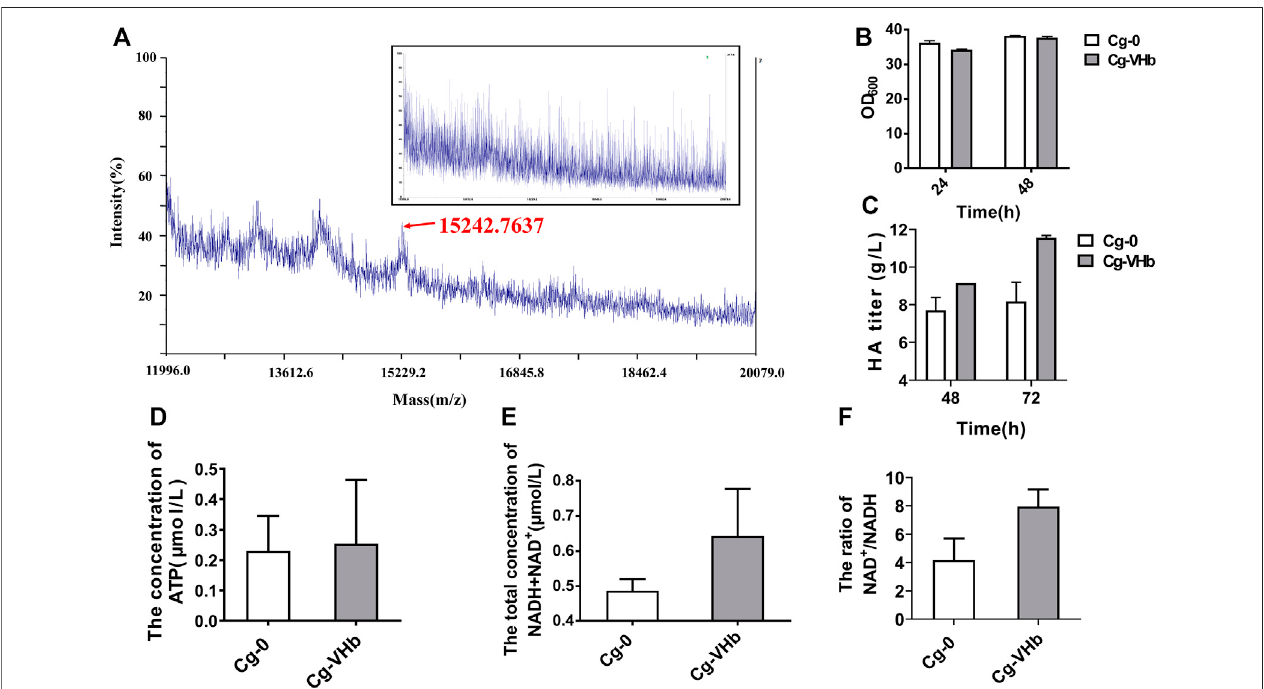
FIGURE 4 | Enhancing HA synthesis via duly expressed VHb in genome. (A) MALDI-TOF-MS. (B) OD 600 . (C) HA titer. (D) ATP concentration. (E) Total concentration of NAD + and NADH. (F) The ratio of NAD + to NADH. In (D) , Cg-VHb and Cg-0 were cultured in a fl ask for 24 h, and in (E , F) , Cg-VHb and Cg-0 were cultured in a fl ask for 48 h. All of the measurements were performed in